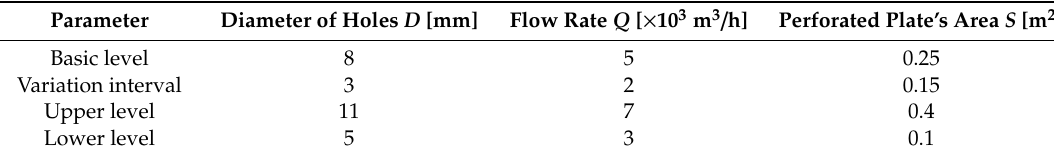
Table 3. Levels and intervals for variation of factors.